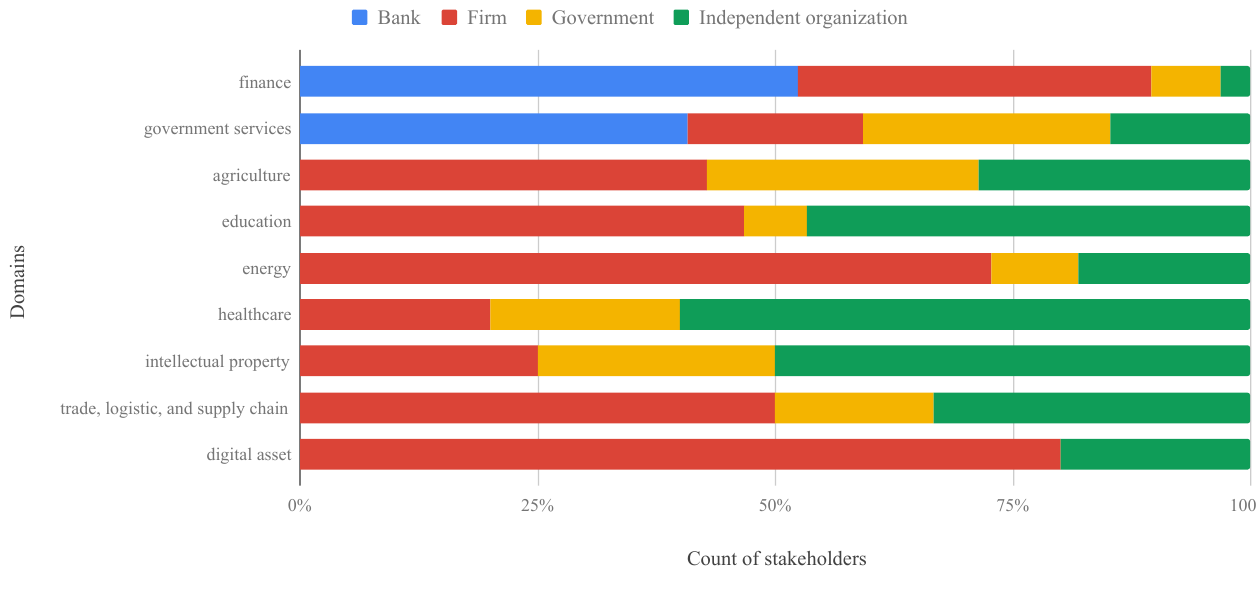
Figure 14. A distribution of agent types by